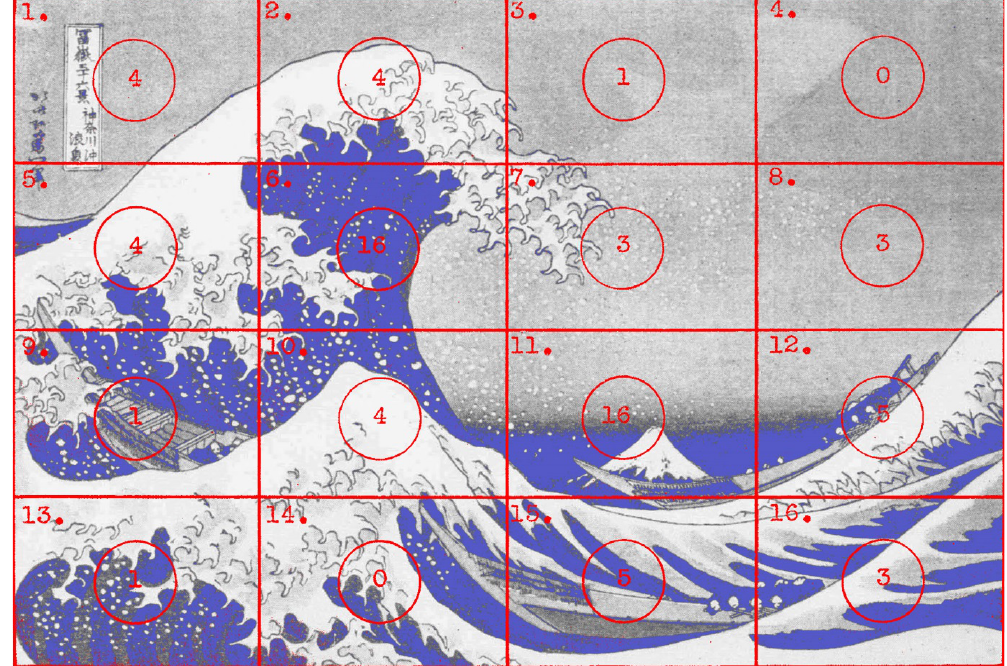
Figure 8. Waves of eye movements 4 . Eye movement records when viewing The Wave by Hokusai. The distribution of the num- ber of long fixations (greater than 667 ms) for 38 observers over the picture. (Adapted from Picture 13 and Plate XLVII in Buswell,